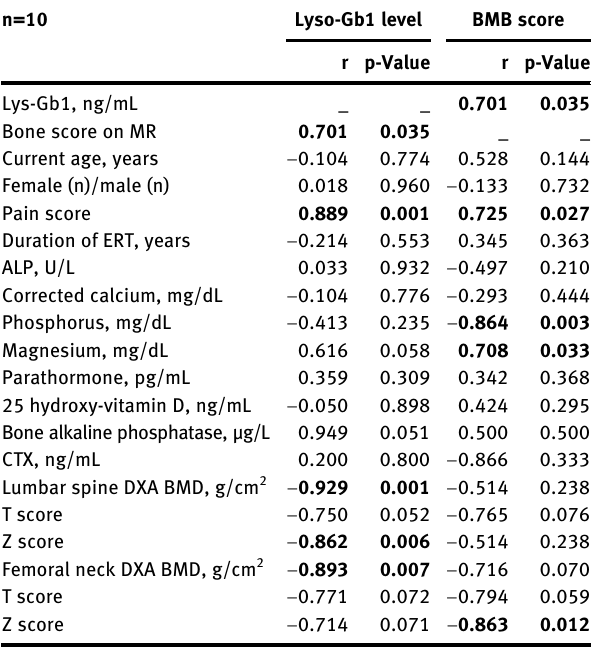
Table  : Correlation between Lyso-Gb  levels and BMB scores with patients ’ parameters.